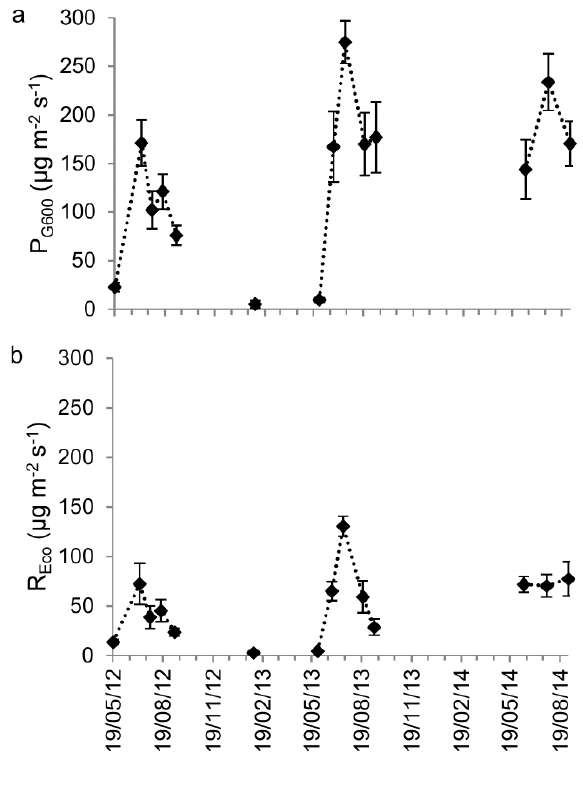
Figure 4. Temporal variation in (a) mean photosynthesis at PPFD of 600 μmol m -2 s -1 (P and (b) mean ecosystem respiration (R carbon equivalents (μg m -2 s -1 ). Error bars are one standard error, n = 6 in 2012 and 2014 (Aclands and Spooners) and n = 3 in 2013 (Spooners